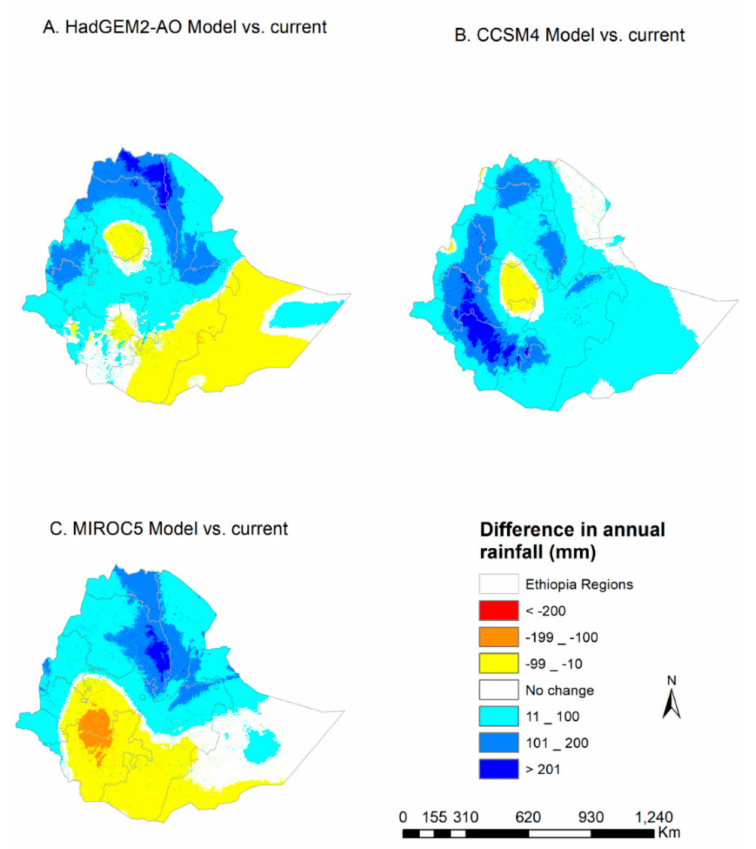
Figure 5. Di ff erences in annual rainfall due to projected climate change between current climate (1970–2000) and three model scenarios (( A ) Hadley global environment model 2 (HadGEM2-AO), ( B ) community climate system model version 4 (CCSM4), and ( C ) model for interdisciplinary research on climate (MIROC5)) representing the 4.5 representative concentration pathway (RCP) for the period of 2041–2060 in Ethiopia. The “no change” interval represents a rainfall di ff erence of ± 10 mm. This interval was considered as “no change” to accommodate di ff erent uncertainties in the climate data and approximations during the